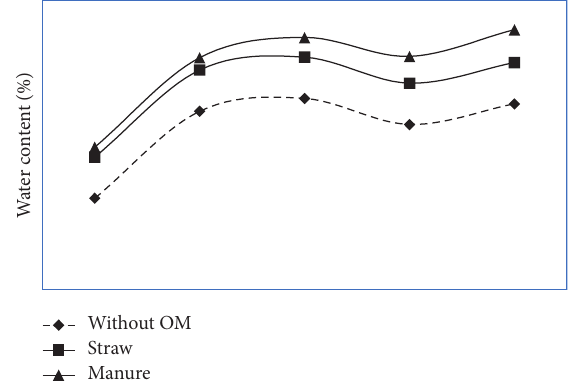
Figure 1: Effect of organic matter (OM) applied in the previous season (rice) on soil water content of the next planting season (soybean I) under the rice-soybean-soybean cropping